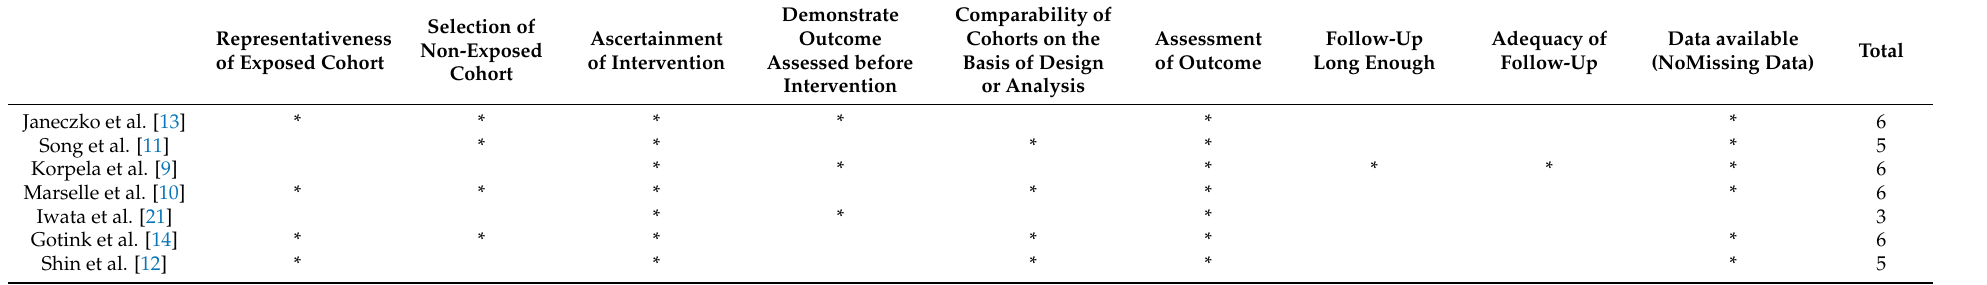
Table 4. Risk of Bias (RoB). The * symbol mean that the study is fulfilling the criteria. Selection of Representativeness of Exposed Cohort